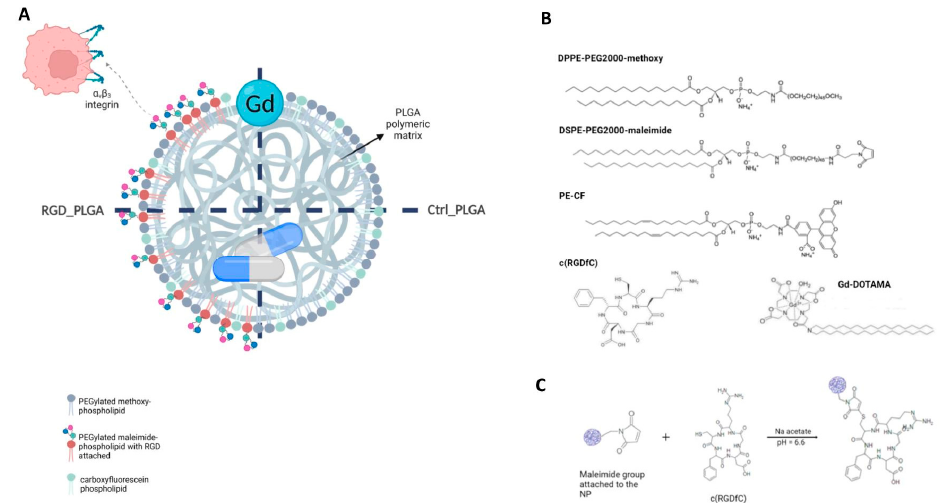
Figure 1. Generation of PLGA-NPs. ( A ) Structures of RGD_PLGA and Ctrl_PLGA-NPs. ( B ) Chemi- cals used for PLGA preparation. ( C ) Chemical reaction for c(RGDfC) ligation. Poly(D,L-lactide-co-glycolide) (50:50, mol wt 30,000–60,000) (PLGA), poly vinyl alcohol (mol wt 31,000–50,000) (PVA), Trimethylsilylpropanoic acid (TSP, NMR standard) so- dium chloride, sodium acetate, HEPES (4-(2-hydroxyethyl)-1-piperazineethane-sulfonic